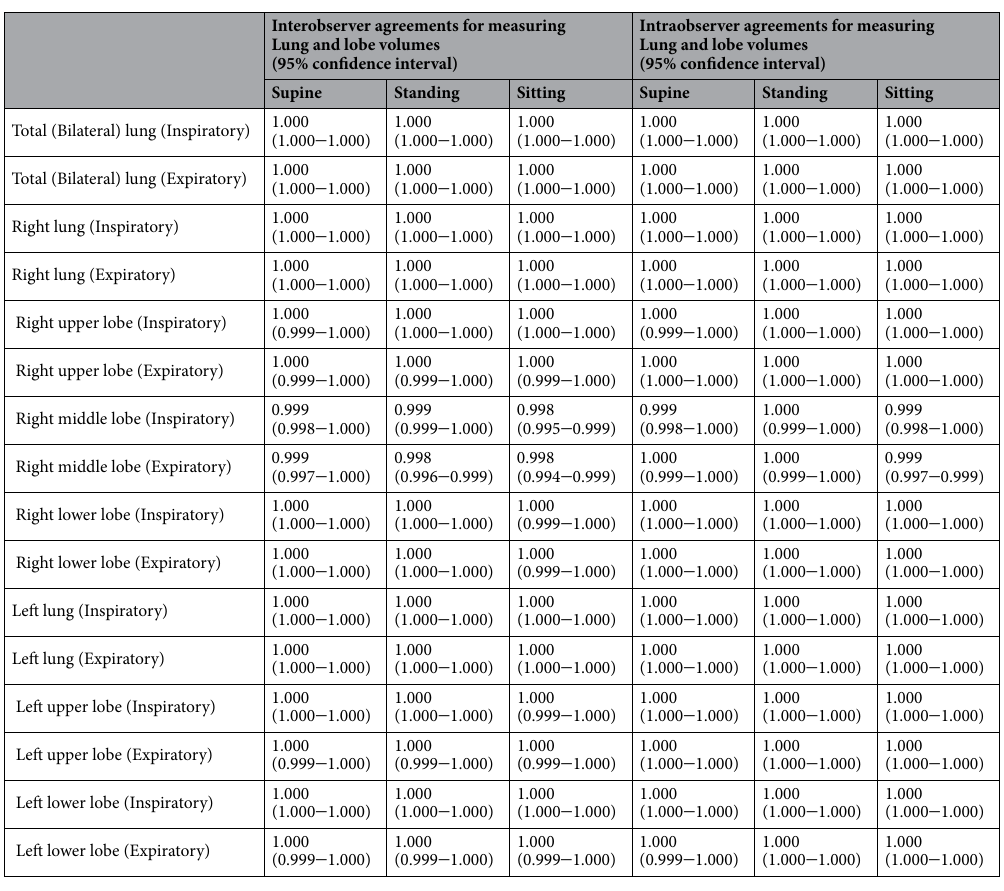
Table 6. Interobserver and intraobserver agreements (intraclass-correlation coefficients) for measuring inspiratory and expiratory lung and lobe volumes as determined using CT in the supine, standing, and sitting positions (the first 20 of 100